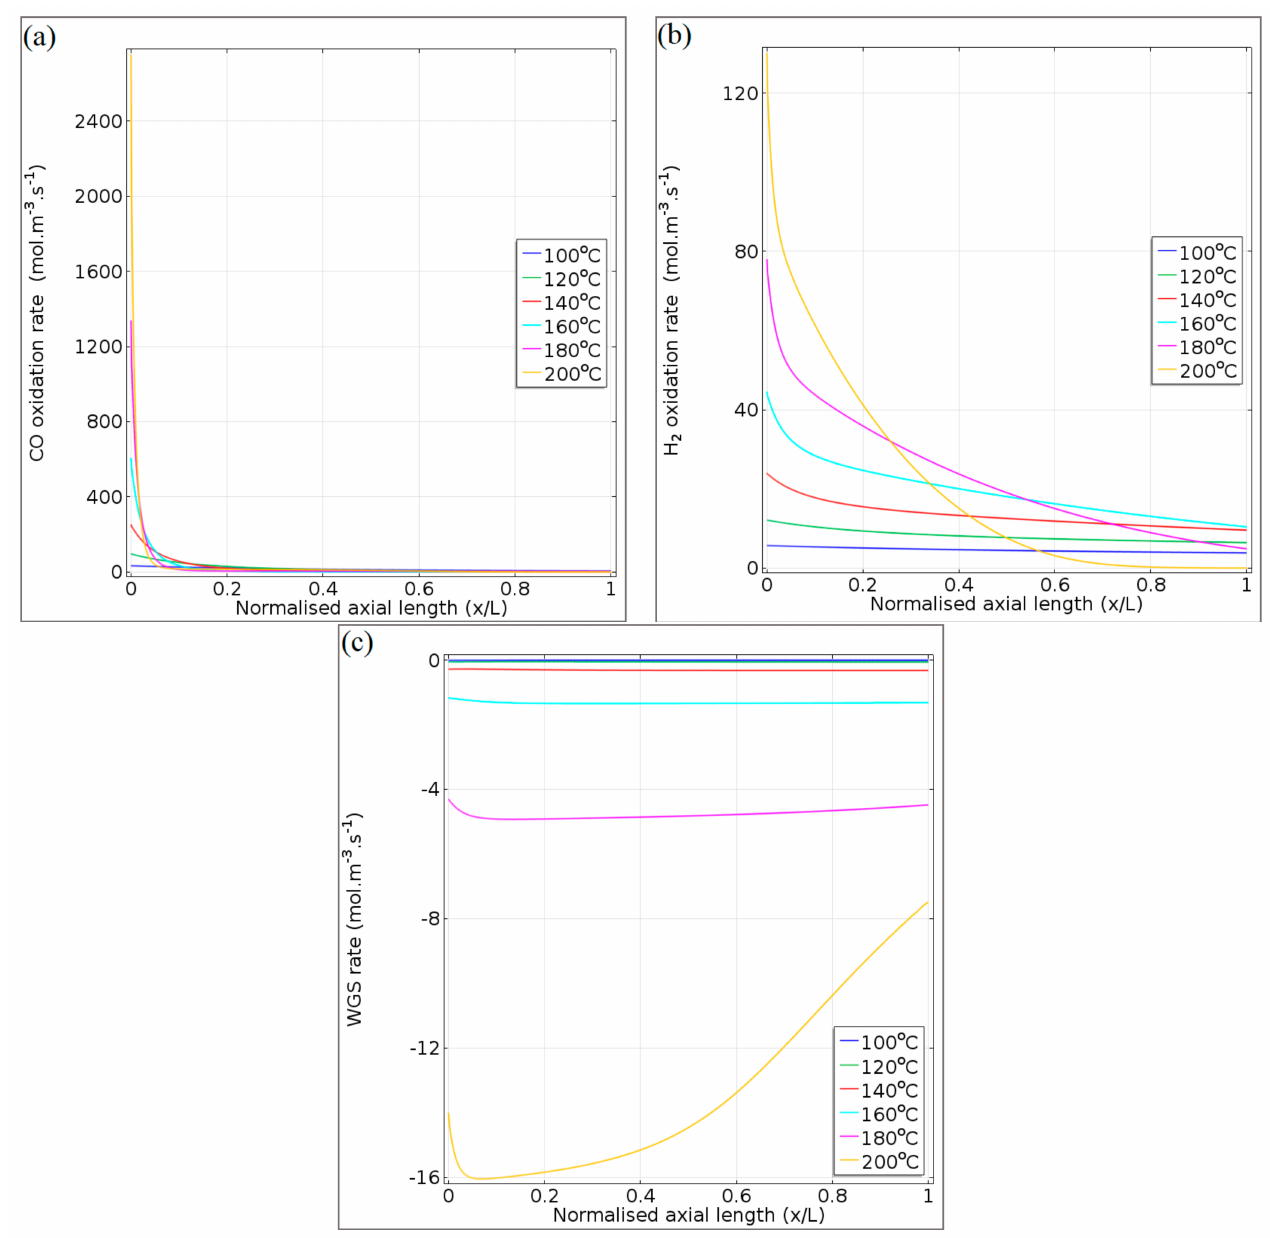
Figure 9. Reaction rate profiles of ( a ) CO oxidation, ( b ) H 2 oxidation, and ( c ) reversible WGS, along the normalised axial length of the microchannel. Reaction conditions: temperatures 100–200 ◦ C and space velocity 65.2 NL g cat − 1 h − 1